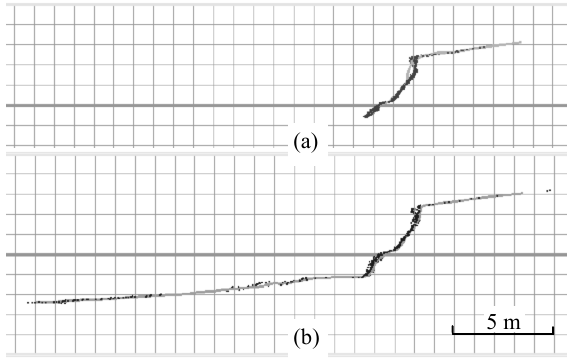
Figure 9. Example of a cross section (P4), Argilito area, Chavantes reservoir: (a) August, 2013 and (b) November, 2013.